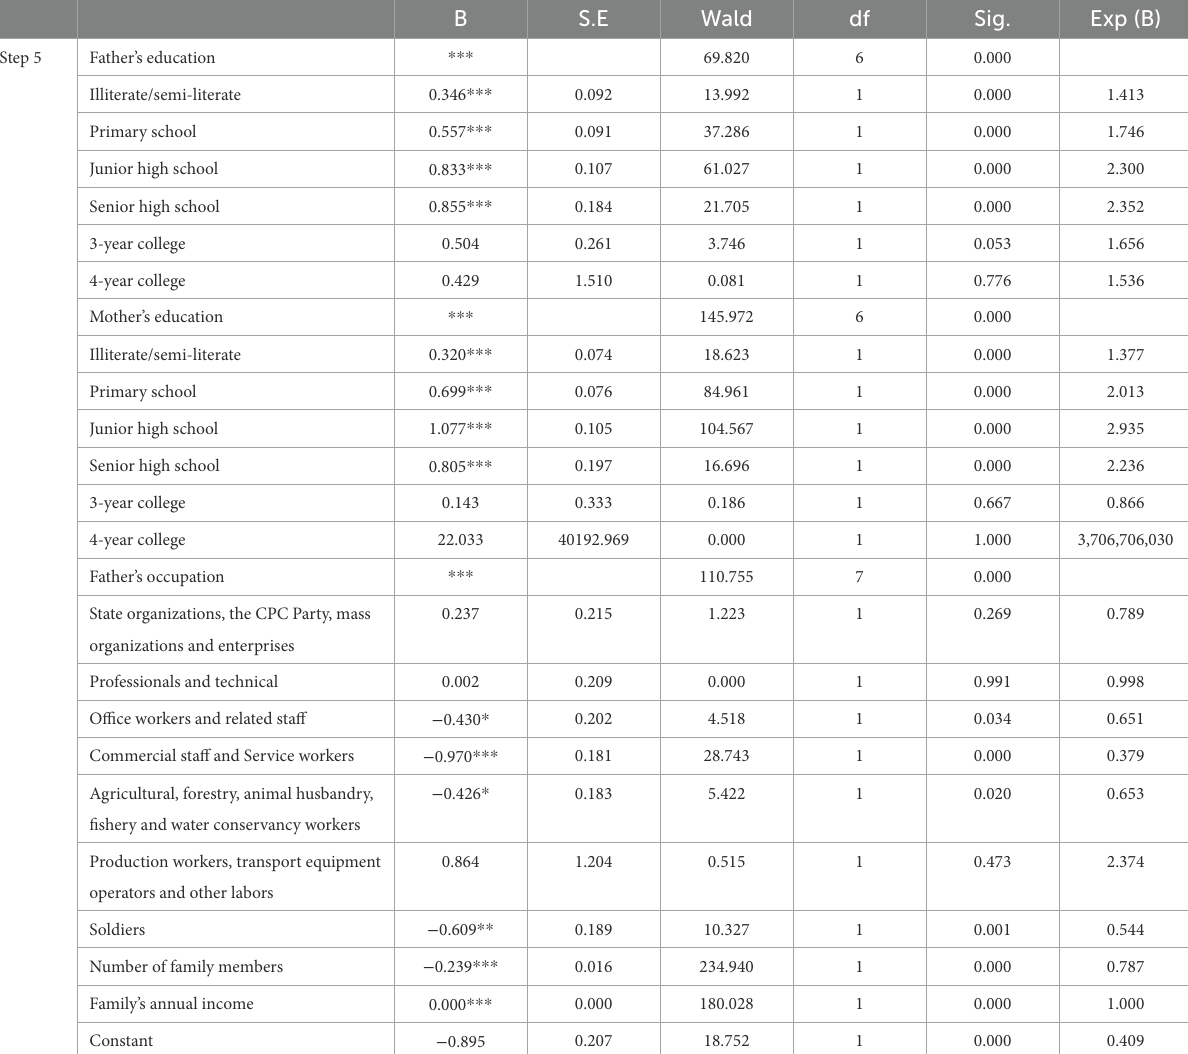
TABLE 7 Variables in the equation (Forward: